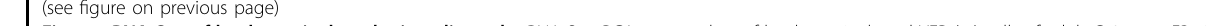
Fig. 1 scRNA-Seq of lumbar spinal cord microglia. a – d scRNA-Seq PCA scatter plots of lumbar spinal cord YFP ( + ) cells of adult Cx3cr1-creER-yfp / + ; + / + heterozygous animals at different timepoints after sciatic nerve injury. The vast majority of microglia in naive animal were in G1 phase of the cell cycle ( a ), a substantial portion of microglia 1 day after nerve injury were in S phase of the cell cycle ( b ), and many microglia were in G2/M phase of the cell cycle 2 days ( c ) and 3 days ( d ) after nerve injury. Note that the S-phase cells appeared one day ( b ) before the appearance of G2/M-phase cells ( c ), and the distribution patterns of S phase cells were different between 1 day ( b ) and 2 days ( c ) after nerve injury. The distribution patterns of G2/M phase cells were also different between 2 days ( c ) and 3 days ( d ) after nerve injury. e Proportion of microglia cells expressing Myc or Mki67 from scRNA-Seq analysis. Myc was expressed in a higher proportion of microglia 1 day after nerve injury, and Mki67 was expressed in a higher proportion of microglia 2 days after nerve injury. f Violin plot of scRNA-Seq showing that a cluster of microglia transiently increased Myc expression on day 1 after nerve injury, and the expression returned to baseline by day 2. g , h qRT-PCR of sorted microglia from the lumbar spinal cord of adult Cx3cr1-creER-yfp/ + ; + / + animals ( g ) and qRT-PCR of RiboTag enriched microglia mRNA from lumbar spinal cord ( h ). Myc was transiently upregulated in the ipsilateral lumbar cord microglia on day 1 after nerve injury, and the expression returned to baseline by day 2 after nerve injury. Analyses are two-way ANOVA with Sidak ’ s multiple-comparison test, n = 4 – 6, means ± SEM, **** P < 0.0001; ns, not signi fi